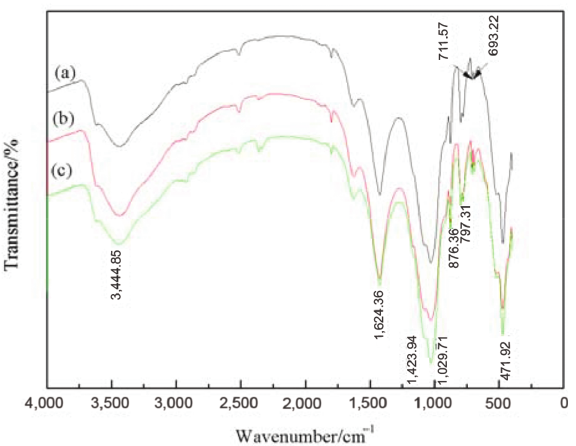
Figure 8: FT-IR spectra of leaching slags under different sodium citrate contents: (a) [Na 3 C 6 H 5 O 7 ] 0 mol/L − 1 ; (b) [Na 3 C 6 H 5 O 7